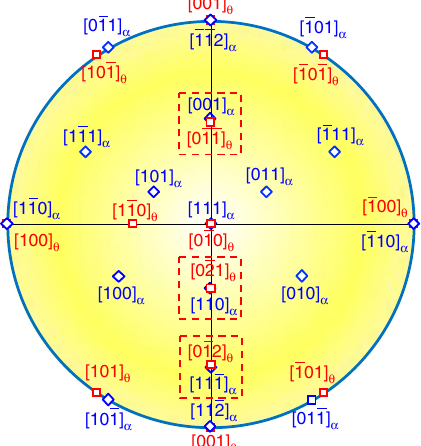
Fig. 2 Crystallographic analysis of orientation relationship (OR) between ferrite and cementite. Stereographic projection in [111] α orientation showing coincident or near coincident zones with cementite following the Bagaryatsky OR. The observed three variants are highlighted with square boxes. Blue diamonds are re fl ections from ferrite and red squares are from cementite